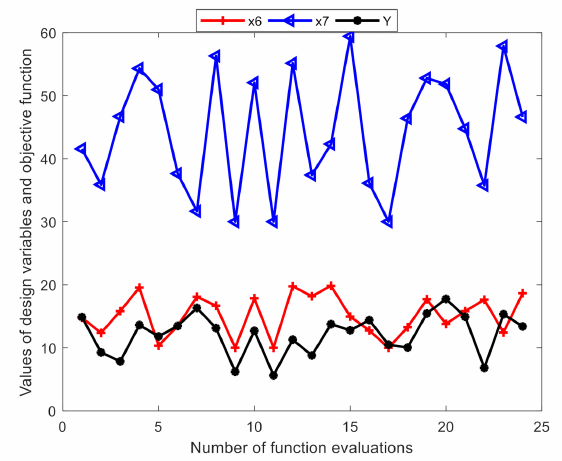
Figure 22. Trends of design variables x 6 , x 7 and objective function obtained by